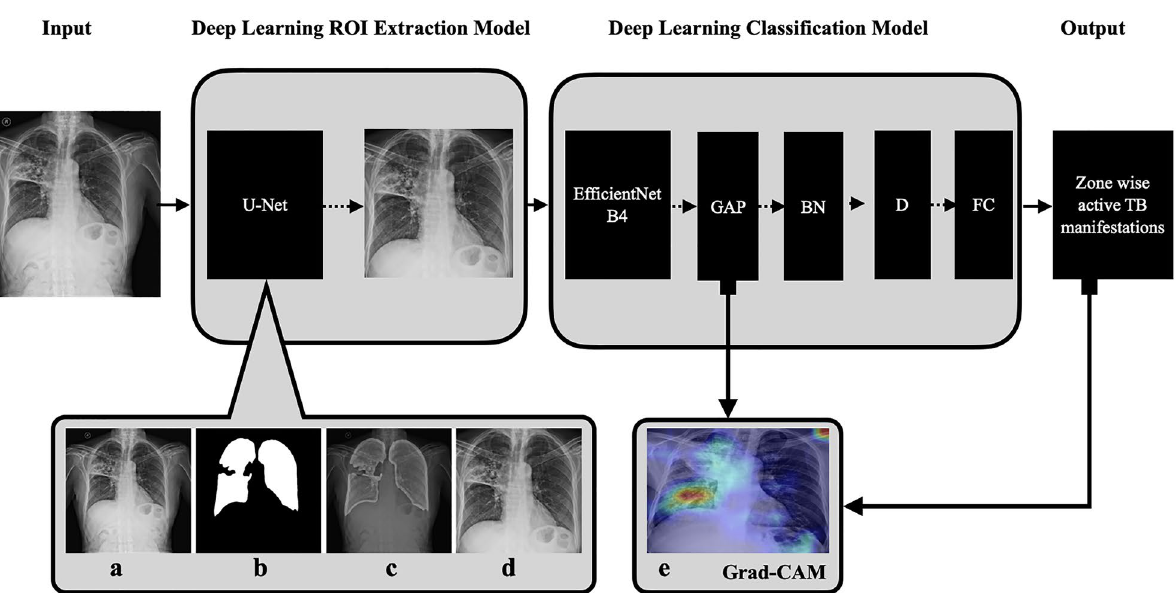
Figure 6. Basic outline of the network architecture. Input—image of chest radiograph. ROI region of interest. In the ROI extraction model: ( a ) original chest X-ray, ( b ) mask of lung generated by U-Net, ( c ) mask overlay to original chest X-ray, and ( d ) final segmented image of the lungs based on mask in 380 × 380 size. ( e ) Grad- CAM visualisation. Pre-trained model—EfficientNetB4 trained on ImageNet without the final classifier layer. GAP global average pooling, BN batch normalisation layer, D dropout layer, FC fully connected classifier with 44 outputs. Due to complexity we omitted activation layer and classifier activation functions. The outputs are parenchymal: opacity, fibrosis, collapse, cavity, calcification (lung zone wise). Pleural: thickening, pneumothorax, effusion and overall: tracheal shift, volume loss, mediastinal shift, emphysema (lung